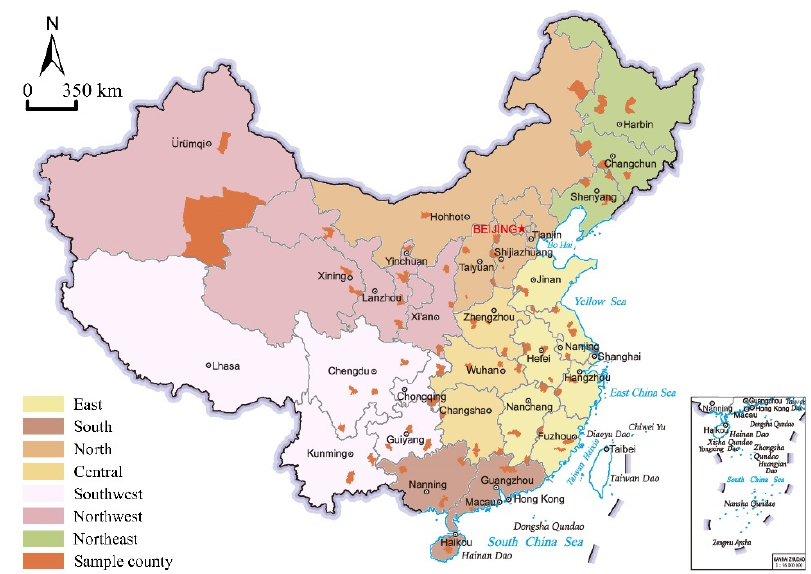
Figure 2. Overview of the study area (Source: by the authors).